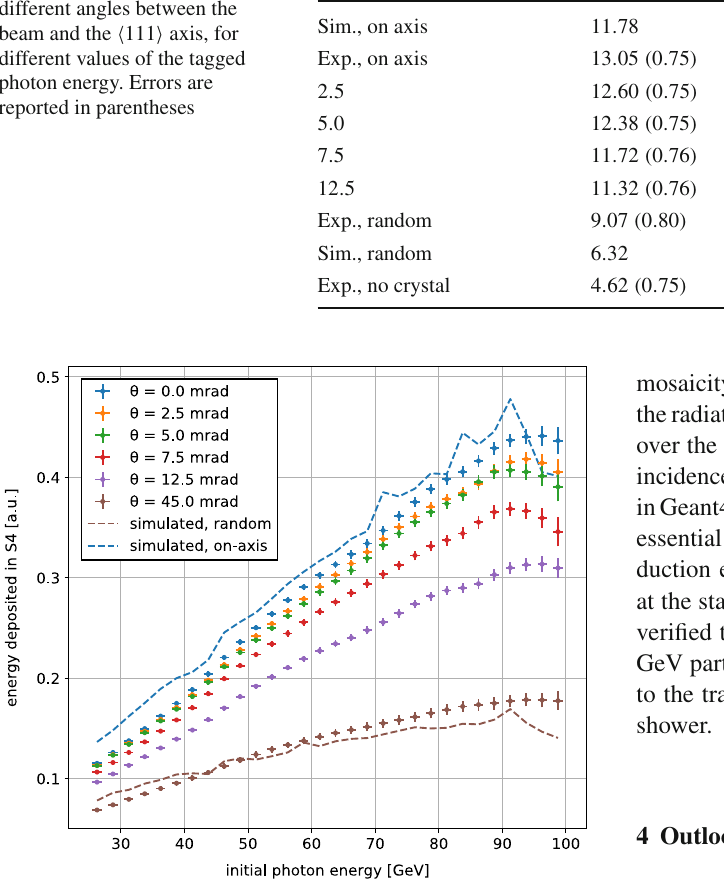
Fig. 3 Energy deposited in the S4 plastic scintillator as a function of the tagged photon energy, at different angles between the beam and the (cid:2) 111 (cid:3) axis and in the random orientation (45 mrad). The points (dashed lines) represent the experimental data (simulated